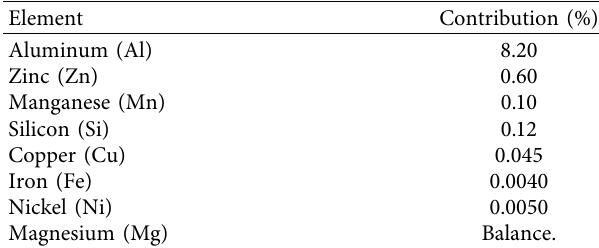
Table 1: Chemical composition of AZ80 magnesium